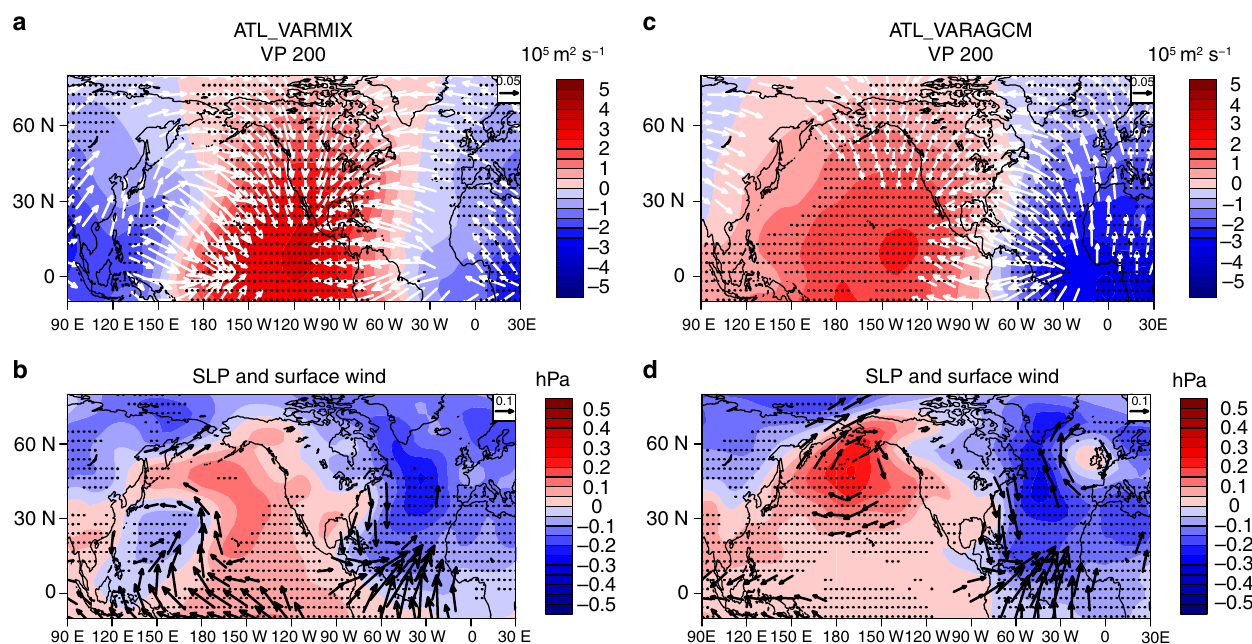
Figure 5 | Responses of atmospheric circulation to Atlantic multidecadal oscillation SST forcing in the ATL_VARMIX and ATL_VARAGCM. ( a ) 200hPa velocity potential (shading, units: 10 5 m 2 s (cid:2) 1 ) and divergent wind (vectors, units: ms (cid:2) 1 ; omitted below 0.05ms (cid:2) 1 ) anomalies in response to the Atlantic multidecadal oscillation (AMO) forcing in the ATL_VARMIX simulations, shown as regressions onto the normalized AMO index at decadal timescales. ( b ) As in a , but for the sea level pressure (shading, units: hPa) and surface winds (vectors, units: ms (cid:2) 1 ; omitted below 0.1ms (cid:2) 1 ). ( c , d ) As in a and b , but based on the data from the ATL_VARAGCM simulations. Dotted shading in a – d stands for the regression coefficients significant at the 95% confidence level. The long-term linear trends for 1900–2013 in all variables were removed before the regression